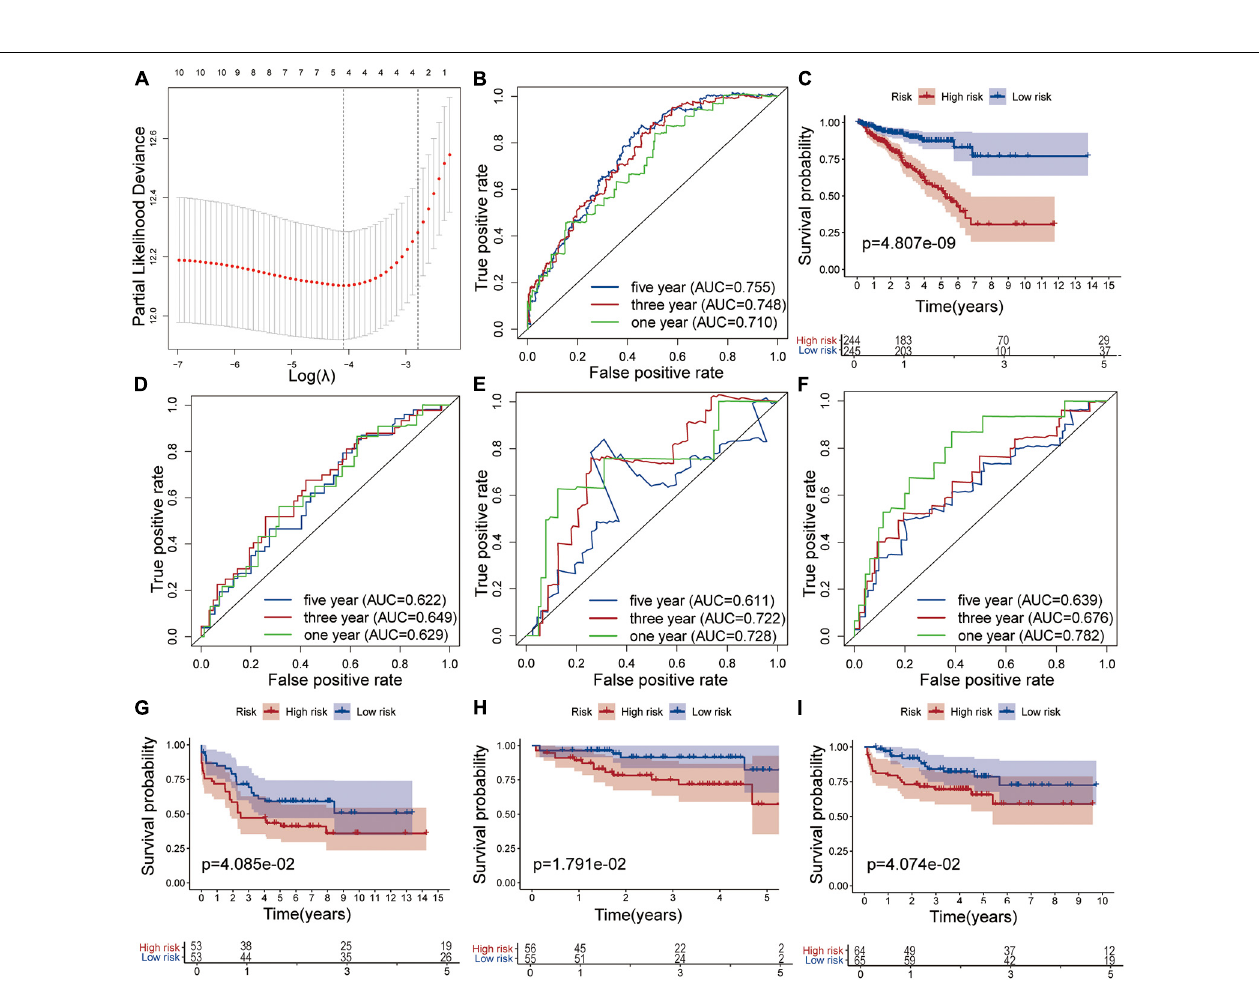
FIGURE 2 | Development and validation of the risk model. (A) Tuning parameter ( λ ) selection in the LASSO model used 10-fold cross-validation via the maximum criteria. Time-dependent ROC curve analysis of the prognostic model in the TCGA cohort (B) , in the GSE54460 cohort (D) , in the GSE70768 cohort (E) and in the MKSCC cohort (F) . Kaplan-Meier curve analysis of high-risk the low-risk groups in the TCGA cohort (C) , in the GSE54460 cohort (G) , in the GSE70768 cohort (H) and in the MKSCC cohort (I) .